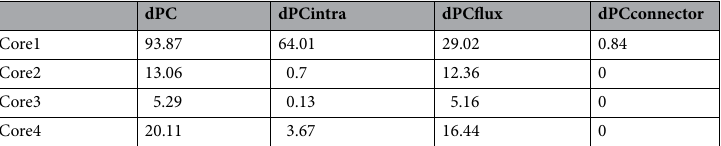
Table 4. Values of dPC index and its three fractions (intra, flux and connector) calculated for predicted four core habitats at the dispersal scenario of 70 km (number of core habitats are available in Fig.